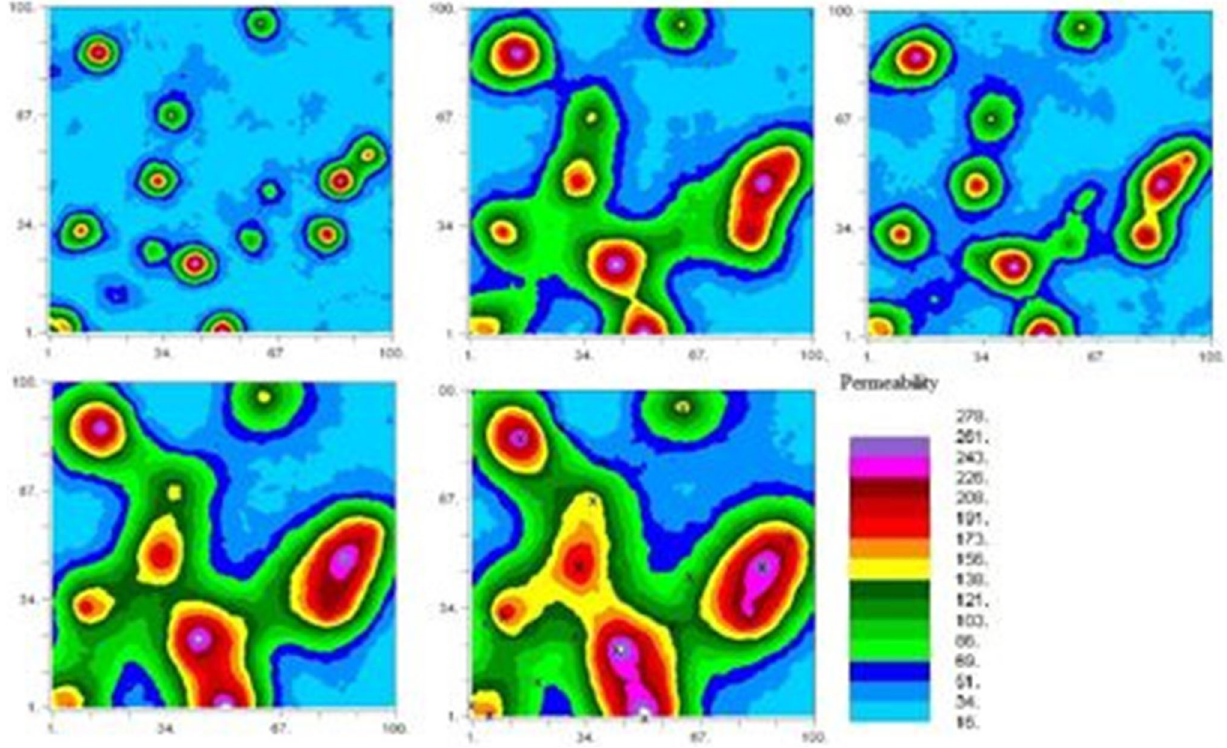
Fig. 2 Permeability model generated using the variogram of Fig.